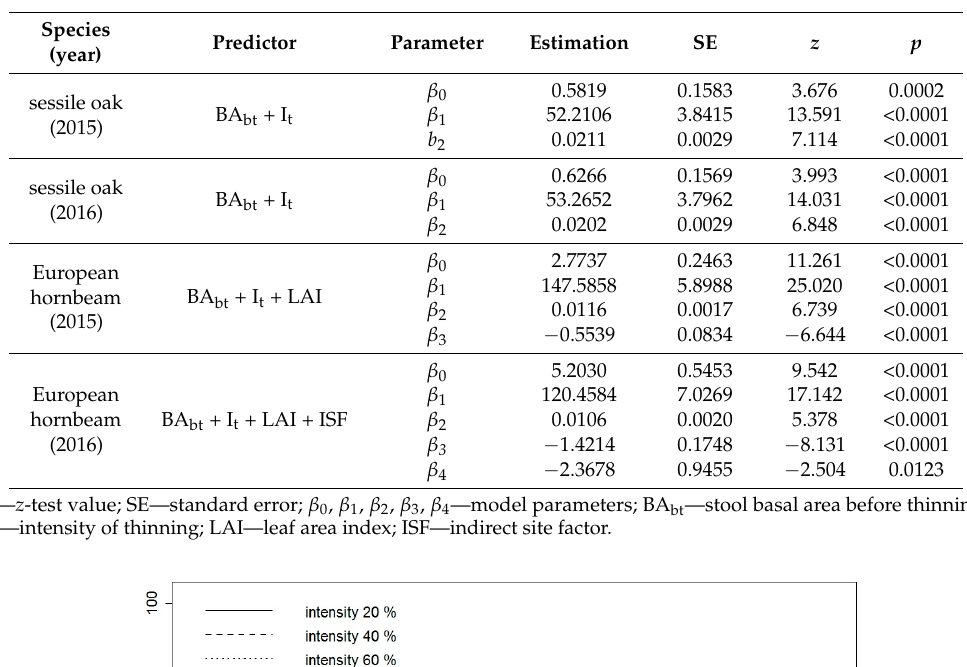
Figure 2. Fitted values of the number of live new European hornbeam sprouts model based on the stool basal area before thinning, thinning intensity, indirect site factor, and leaf area index (2016) (for the purpose of this figure, the mean value of LAI for European hornbeam stools is used).